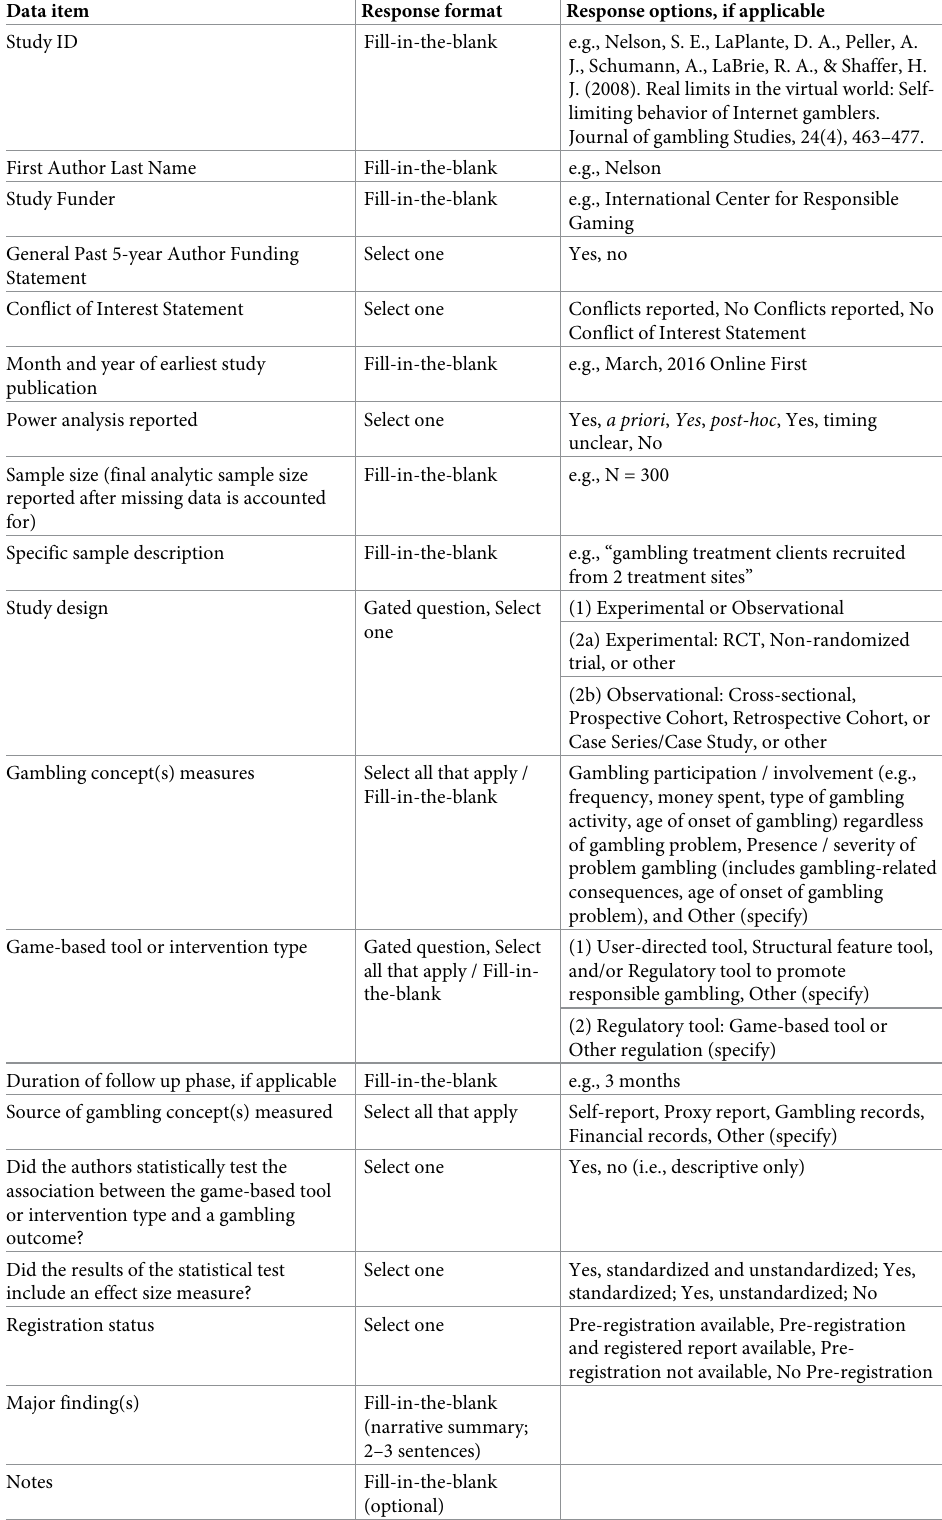
Table 1. Data items, response format and response